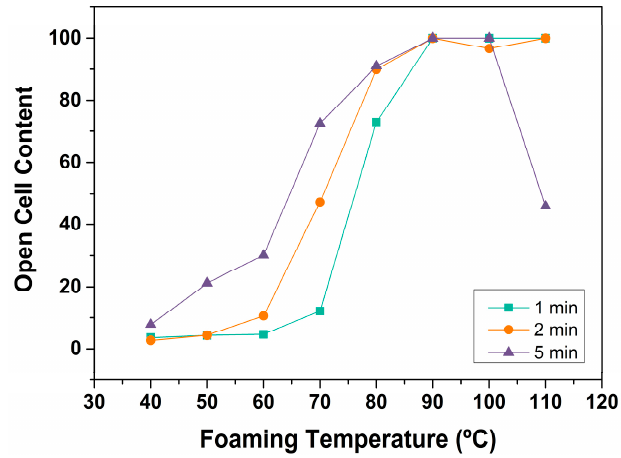
Figure 5. Open cell content as a function of foaming temperature.